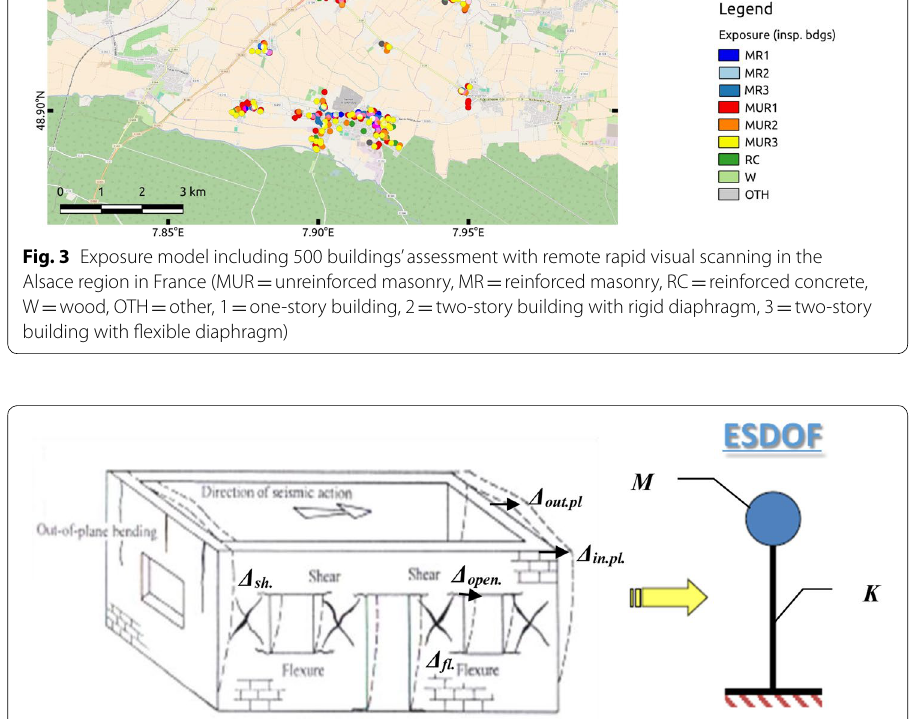
Fig. 4 Equivalent single-degree-of-freedom (ESDOF) representation of typical box-shape unreinforced masonry (URM) building under earthquake-induced loading taking into account typical deformation components in the fundamental mode shape [ Δ sh : horizontal displacement due to shear deformation, Δ fl : horizonal displacement due to flexural deformation, Δ open : horizontal displacement contribution of masonry wall openings, Δ in.pl : in-plane horizontal masonry wall displacement (consists of Δ sh , Δ fl , Δ open ) , Δ out. pl : out-of-plane horizontal masonry wall displacement due to out-of-plane bending, M : ESDOF generalized mass, K : ESDOF generalized